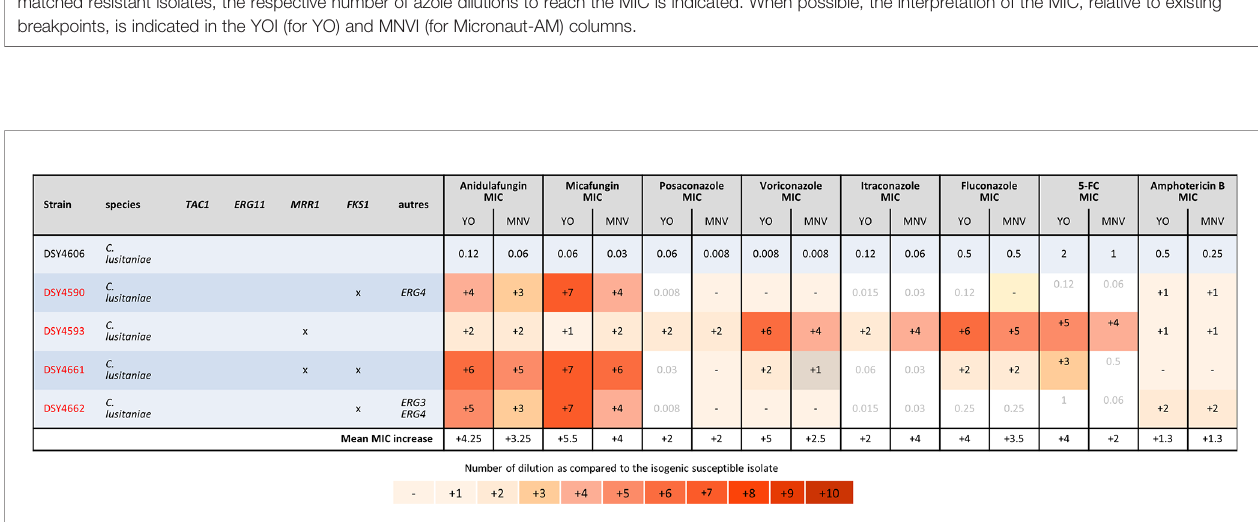
FIGURE 5 | MIC increases of C. lusitaniae resistant strains as compared to the matched susceptible one for YO and MNV. The MIC values are indicated for the susceptible isolate in micrograms per millilliter of drugs, whereas for the matched resistant isolates, the respective number of azole dilutions to reach the MIC is indicated. As none of the drug has breakpoint interpretation in both consortia for C. lusitaniae , we do not indicate any interpretation in this table.